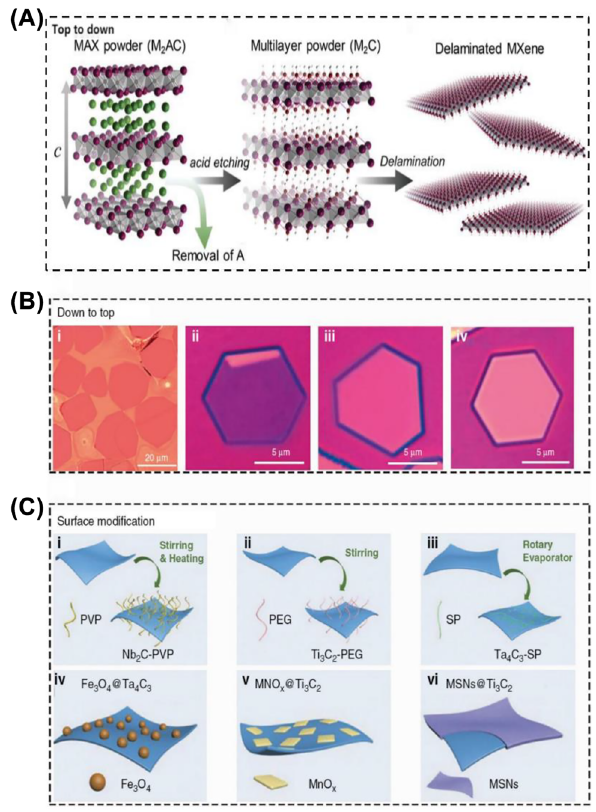
Figure 2: Synthesis and modification of MXene. (A) Schematic diagram of the top-down approach for MXene nanosheets